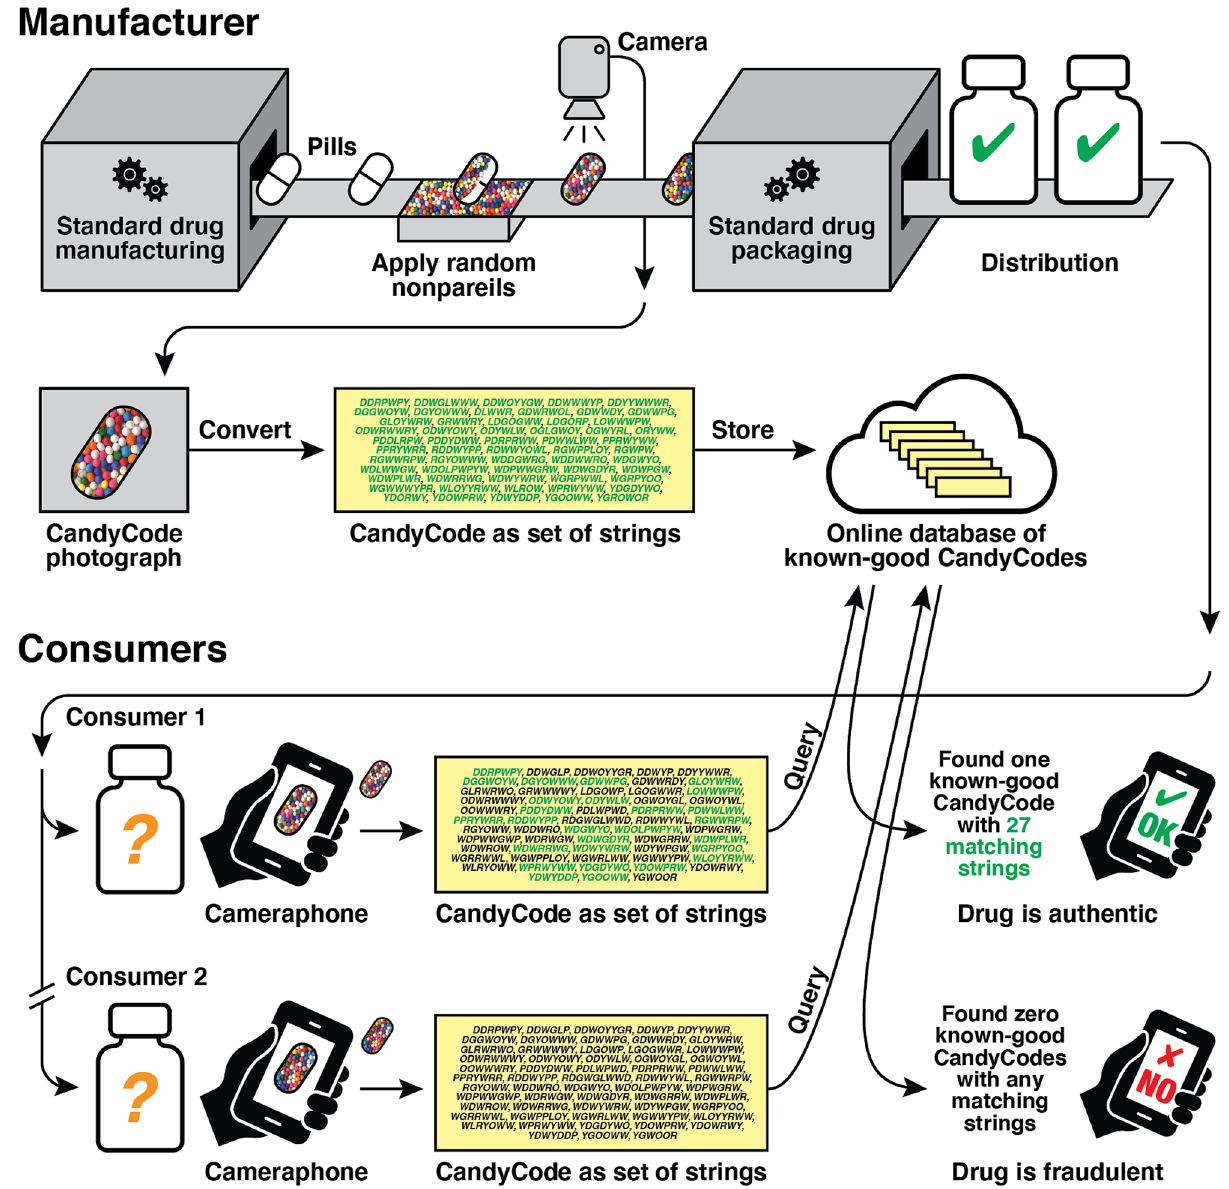
Figure 2. Using CandyCodes to authenticate pharmaceuticals. By randomly affixing a number of distinguishable edible particles (in this case, multicolored nonpareil candies) to each pill after manufacturing, a pharmaceutical company gives each pill a universally-unique “CandyCode.” Each CandyCoded pill is photographed before packaging and distribution, and the pattern of particles in each photo is recorded (in this example, the manufacturer converts each photo into a set of text strings using a process detailed later in this work) and stored in a database of known-good CandyCodes. When a consumer receives the drug and wishes to verify its authenticity, the consumer uses their cameraphone to take a photo of a CandyCoded pill and uploads this photo to the manufacturer’s server, which performs the same pattern conversion and searches for a CandyCode with a matching or similar pattern in the database. In this example, Consumer 1’s CandyCoded pill has 27 strings (shown in green) that match the strings of a known-good CandyCoded pill in the manufacturer’s database, so the server informs Consumer 1 that their medication is authentic. However, Consumer 2’s CandyCode strings have no matches in the database of known-good CandyCodes, so Consumer 2’s drug must not have originated in the manufacturer’s facility and is not authentic, and the server warns Consumer 2 not to consume the